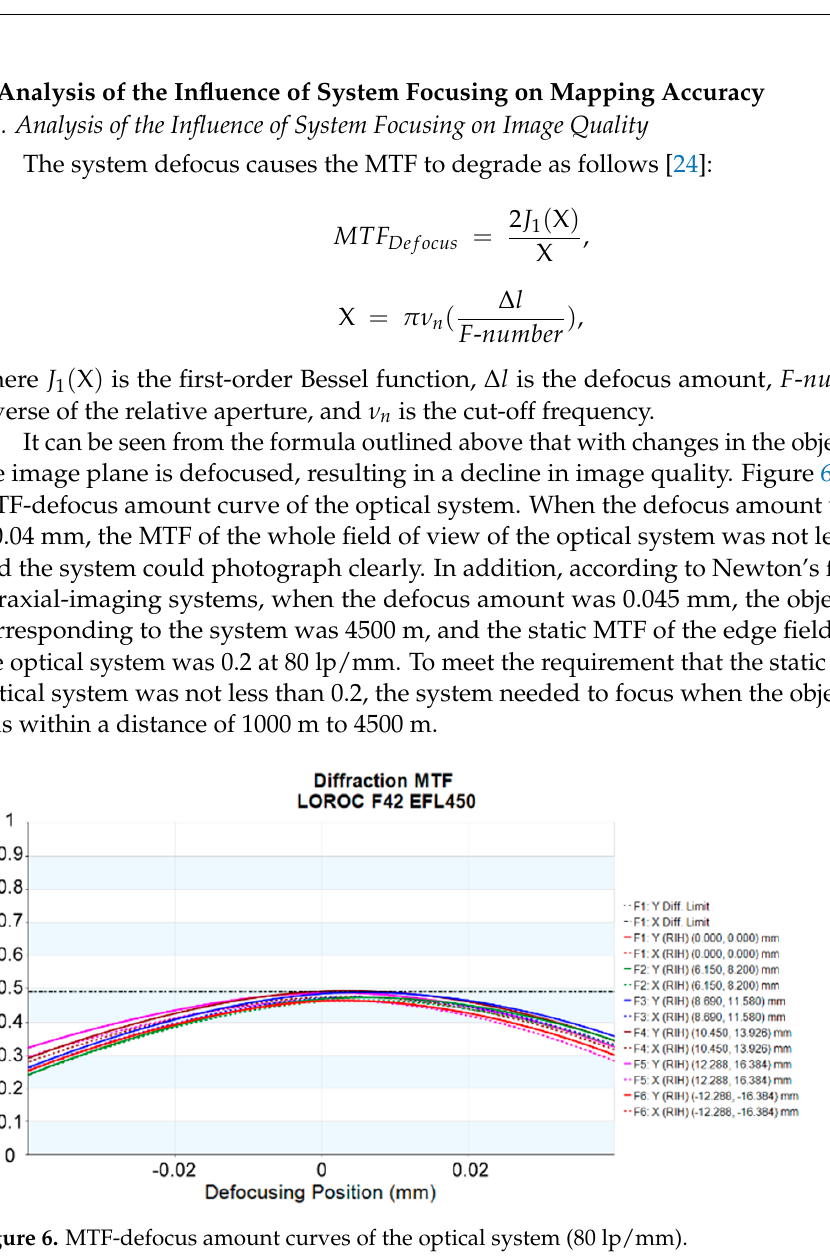
Table 6. Imaging range of optical system after focusing with different